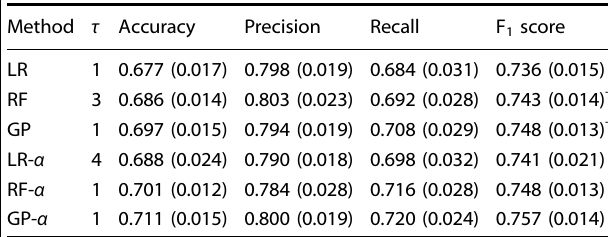
Table 3. Classi fi cation accuracy estimates with their standard deviation (in parentheses) for predicting student response (full response versus otherwise) incorporating past observations and student